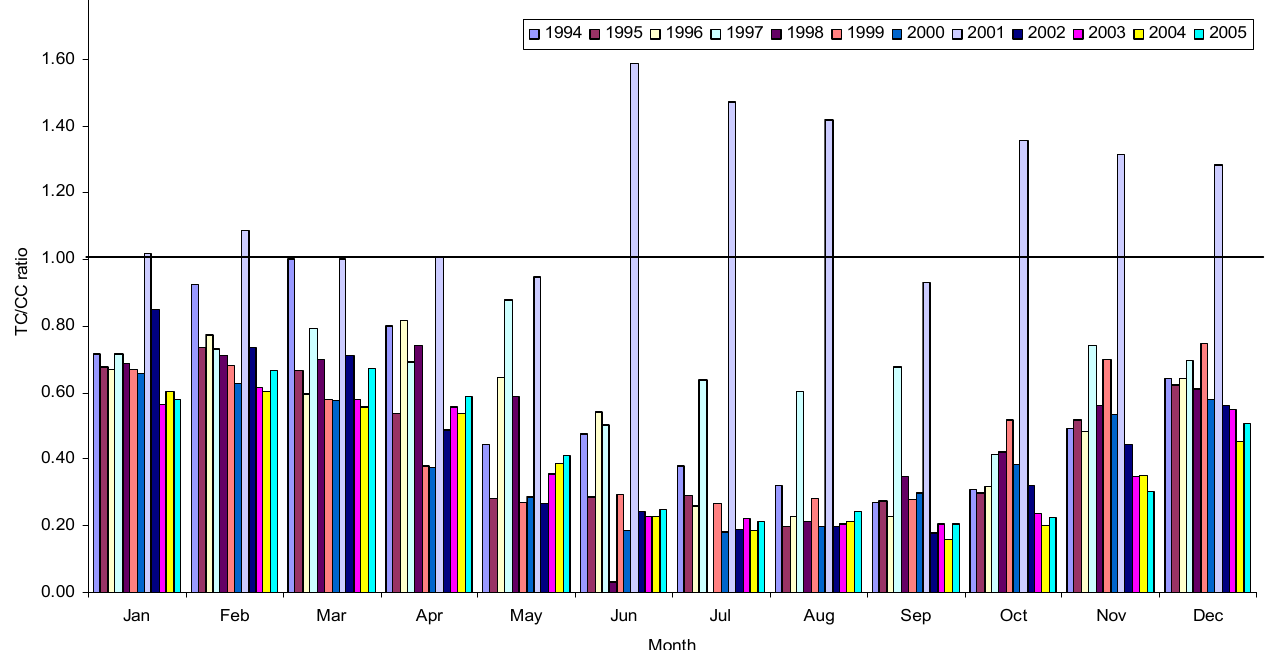
Fig. 2. Average monthly TC/CC ratios at Zeppelin